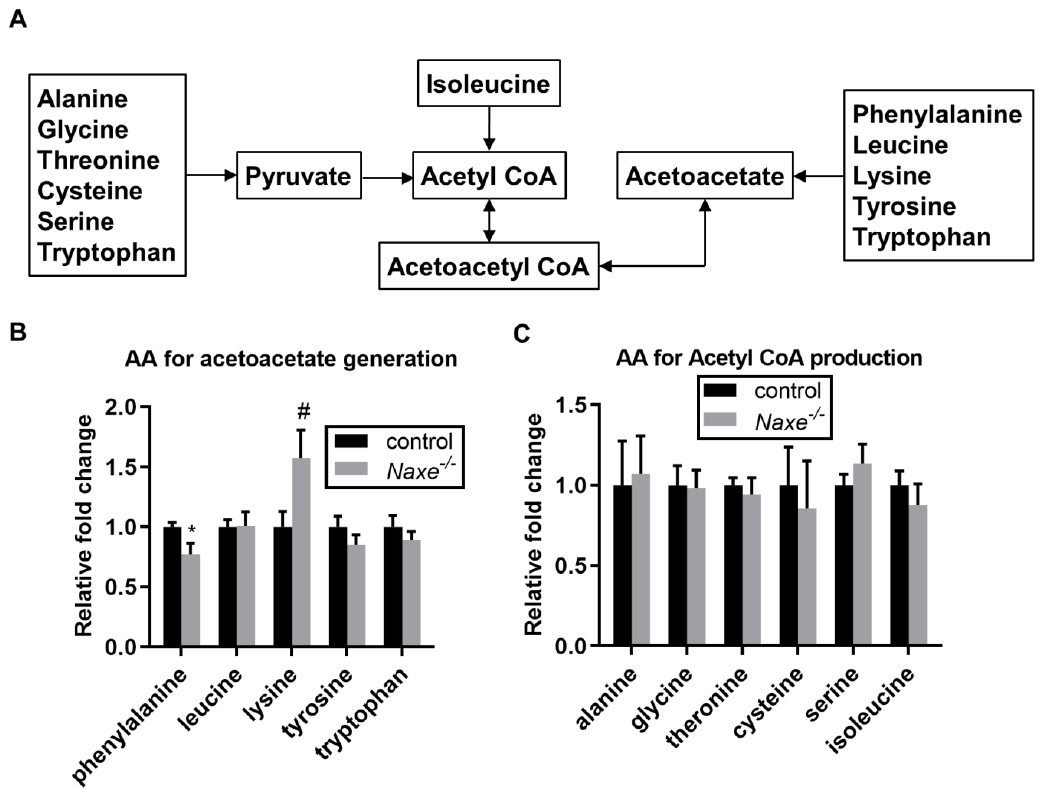
Figure 8. NAXE effect on the content of amino acids that are associated with acetyl - CoA generation. ( A ) Scheme illustrating acetyl-CoA or acetoacetyl-CoA-generating amino acid metabolism. ( B , C ) Relative abundance of detected amino acids that can be used for acetyl-CoA or acetoacetyl CoA-production. Mean ± SE; n = 6 mice per group. AA: amino acids. * p < 0.05; # p = 0.056. 3.4. A Subset of Endogenous NAXE Is Localized in the Mitochondria of Cardiomyocytes Overexpressed full-length NAXE localizes to the mitochondria [31], but the cellular distribution of endogenous NAXE remains unknown. To probe the localization of NAXE in vivo, we purified recombinant human NAXE proteins and generated polyclonal anti- bodies for NAXE. Western blot analysis of whole-cell lysates using this antibody revealed a single band with a molecular mass of 28 kDa (Figure S2), suggesting that the antibody we generated is specific for NAXE. Immunostaining of cardiomyocytes showed a strong signal of endogenous NAXE by the NAXE antibody, and some of the signal colocalized with mitochondria that were marked by MitoTracker Deep Red (Figure 9A). In addition, a substantial amount of NAXE was localized in the mitochondria of HUVECs (Figure 9B). Notably, pronounced colocalization of NAXE with mitochondria occurred in the peri- nuclear region of HUVECs. Our results indicate that NAXE is present in different subcel- lular locations, including mitochondria.